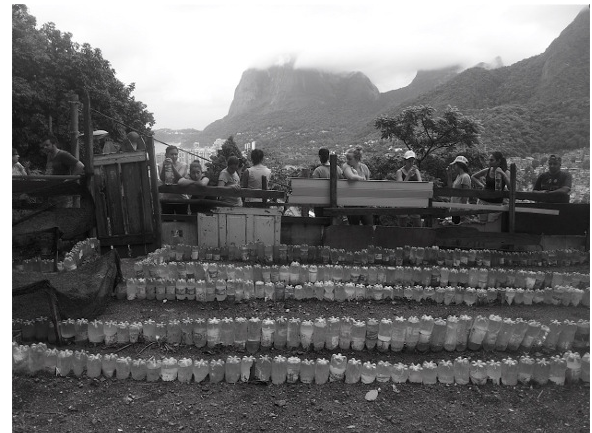
Figure 14. GMF volunteers overlooking the Hortas Cario- cas Macega garden after a long